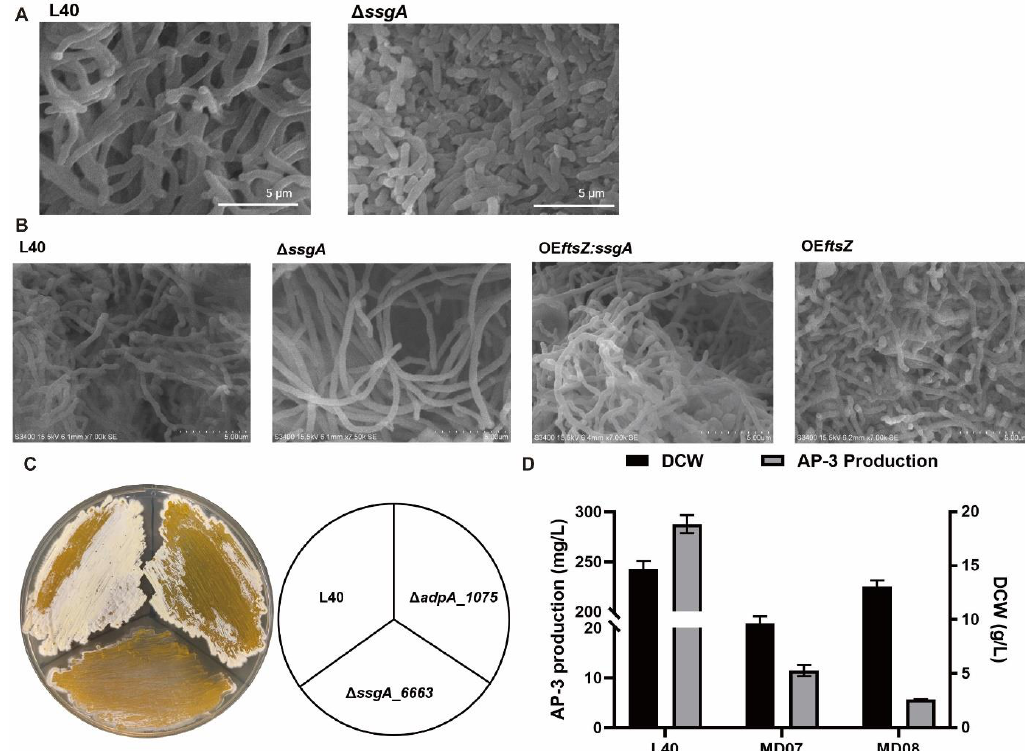
Figure 2. Differences in morphology ( A – C ) and AP-3 production ( D ) between mutant strains and L40 strain. ( A ) Scanning electron micrographs of ssgA_6663 deletion mutant and strain L40 on day 3 of YMG plate culture. Scale bar: 5 μm . Magnification, 7500×. ( B ) Scanning electron microscopic observation of mycelium of strain L40, ssgA_6663 deletion mutant, strain overexpressing ssgA_6663 and ftsZ_5883 in tandem, and mutant with ftsZ_5883 overexpression in liquid seed culture for 16 h. Scale bar: 5 μ m. Magnification, 7500×. ( C ) Phenotypes of control strain L40, ssgA_6663 deletion mutant, and adpA_1075 deletion mutant grown on YMG plates at 28 °C (day 3). ( D ) AP-3 production and cell growth of strains L40, MD07, and MD08. MD07, mutant with ssgA_6663 deletion. MD08, mutant with adpA_1075 deletion. All fermentation experiments were performed in three biological replicates.